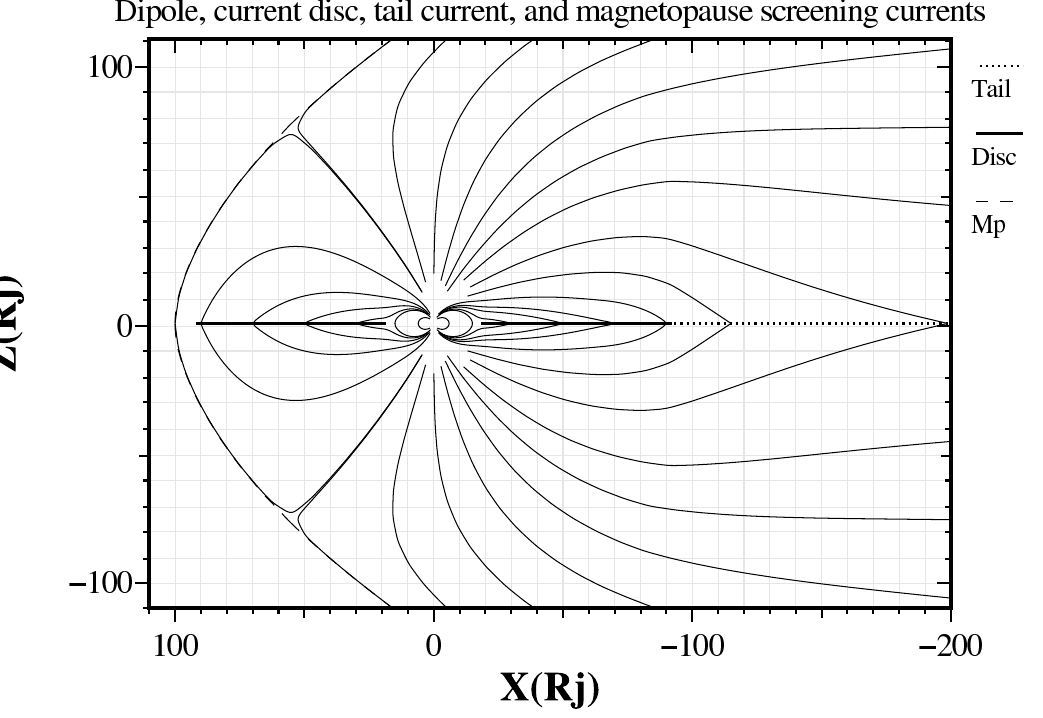
Fig. 7. Noon–midnight meridional cross section. Total magnetic field from all magnetospheric sources screened by the magnetopause currents. Dashed line marks the magnetotail current sheet. The chosen parameters: R ss = 100 R J ; R D1 = 92 . 07 R J ; R D2 = 18 . 4 R J ; B DC = 2 . 5nT. Northward (southward) from the equatorial plane, the magnetic field is directed from (to) Jupiter.